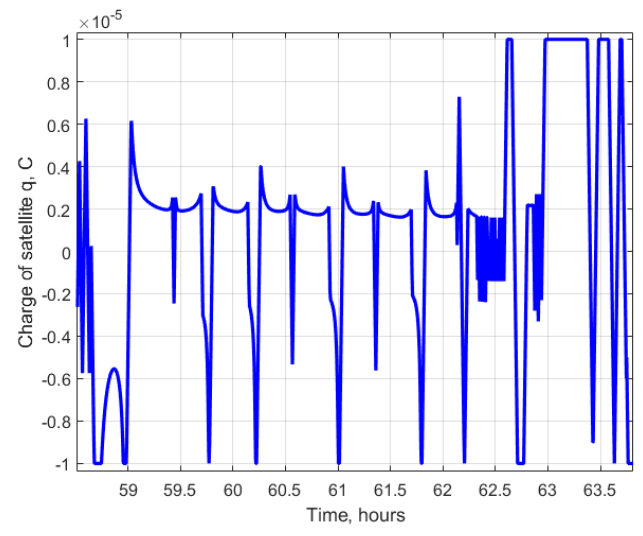
Figure 10. Satellite charge (zoomed).